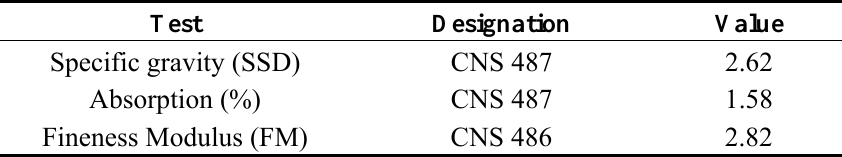
Table 1. The physical properties of the Langyang River